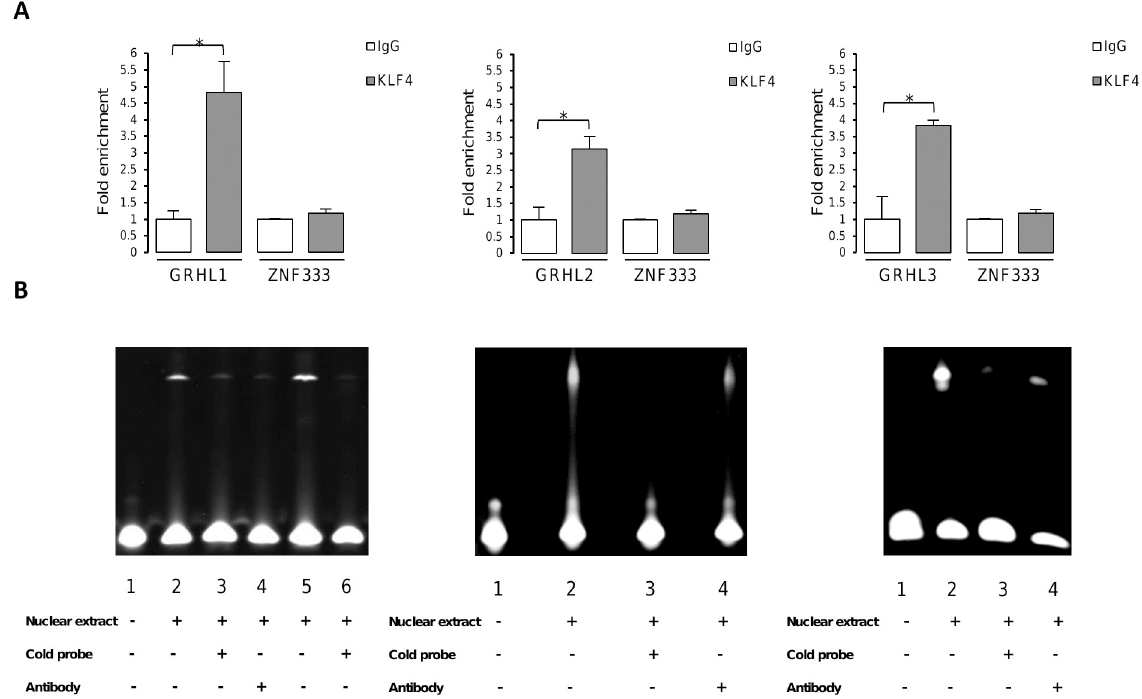
Fig 2. KLF4 binds to the regulatory regions of GRHL genes. ( A ) Quantitative ChIP-PCR analysis of KLF4 occupancy of GRHL1 , GRHL2 and GRHL3 regulatory regions was performed in HEK293 cells transfected with pcDNA3.1-HA-KLF4 FL. ZNF333 was used to identify non- specific interactions. Chromatin was immunoprecipitated with anti-KLF4 antibody or nonspecific antibody. The amount of DNA amplified from immunoprecipitated DNA was normalized to that amplified from input DNA. Data are shown as means ± SEM from experiments independently performed in triplicate, � significantly different at p � 0.05. ( B ) EMSA analysis performed with probes including KLF4 binding sequences: left panel–in the region -409/-400 (lane 2) or -409/-400 with the minor frequency allele of SNP rs115898376 (C/T) (lane 5) of the GRHL1 promoter; central panel–in the region -650/-641 (lane 2) of the GRHL2 promoter; right panel–in the region -1302/-1293 (lane 2) of the GRHL3 promoter. Lane 1: probe only. Cold probe: unlabeled double-stranded oligonucleotides including -409/-400 (left panel, lane 3) or -409/-400 with SNP rs115898376 (C/T) (left panel, lane 6) or -650/-641 (central panel, lane 3) or -1302/-1293 (right panel, lane 3) regions of GRHL genes (100-fold molar excess of competitors). Where indicated, 3 μ g anti-KLF4 antibody was added per lane (ab106629,